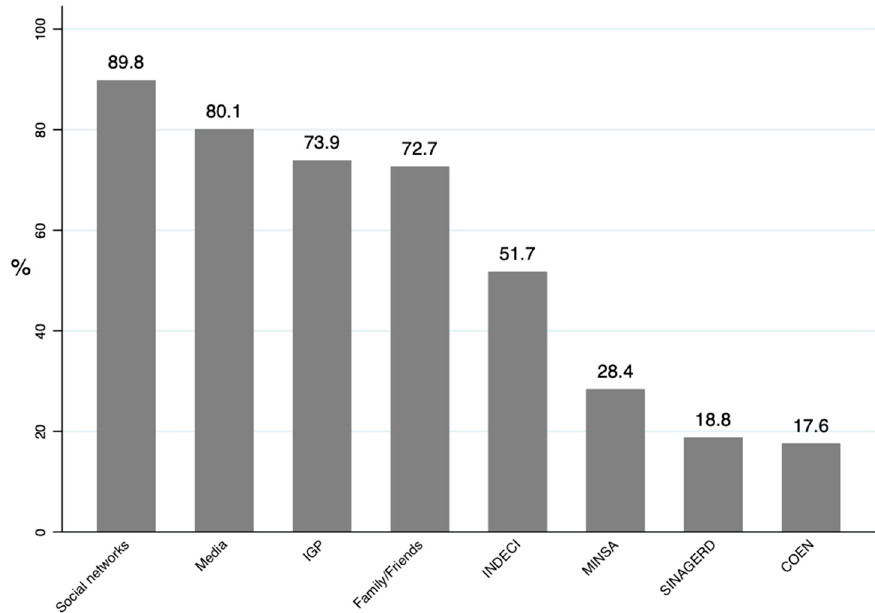
Figure 1. Source of seismic information reported by participants.